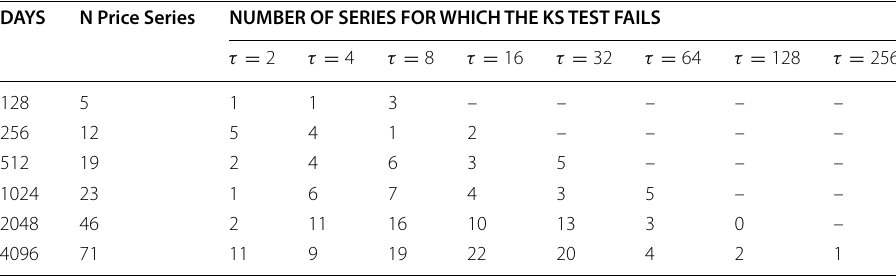
Table 8 Number of series for which the KS tests fail depending on the length of the series and τ DAYS N Price Series NUMBER OF SERIES FOR WHICH THE KS TEST FAILS